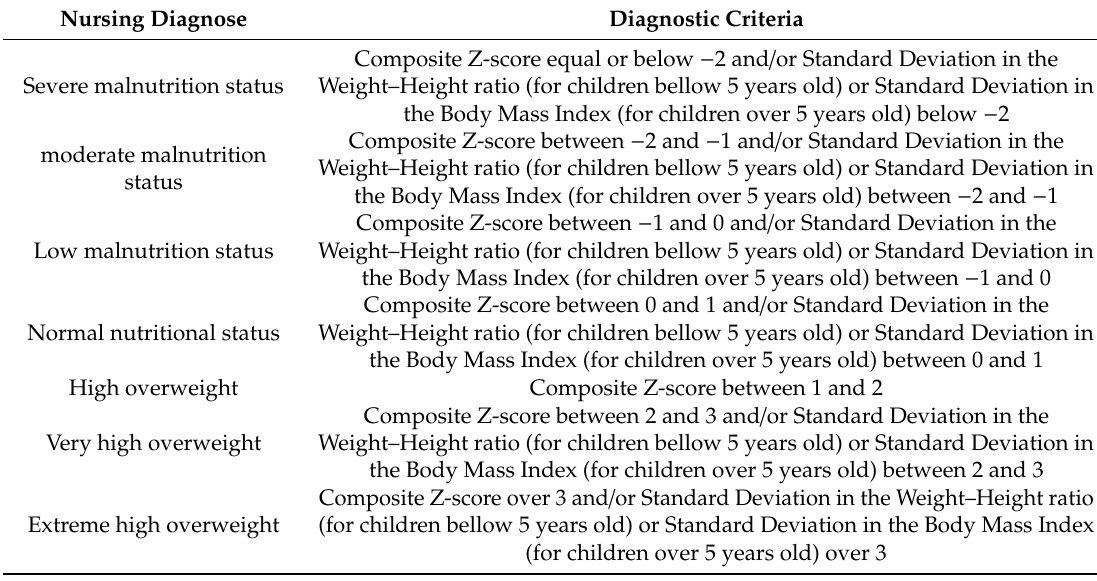
Table 1. Nursing Diagnoses and Diagnostic Criteria for “Nutritional Status” in Children. Nursing Diagnose Diagnostic